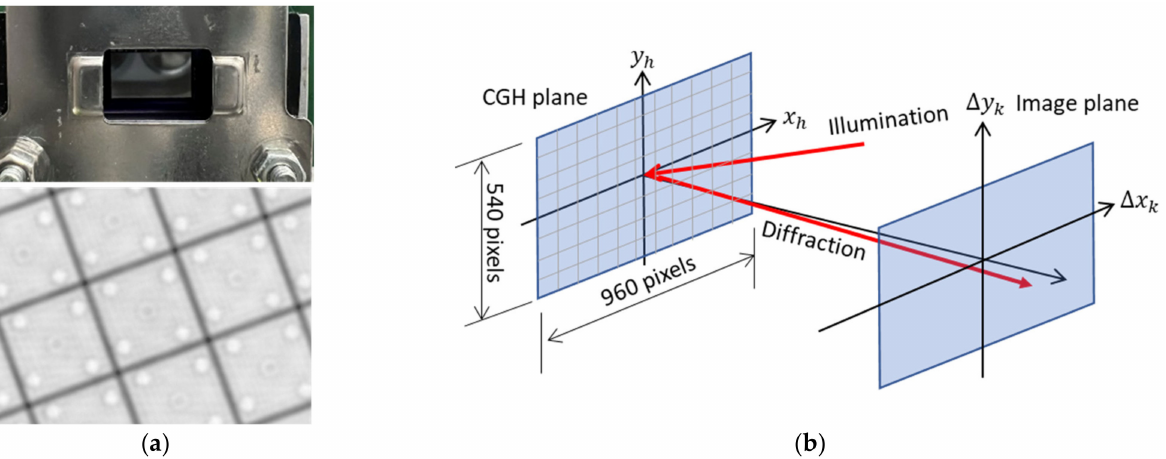
Figure 1. ( a ) The TI-PLM and image of pixels; ( b ) schematic diagram of the CGH plane ( x h , y h ) and the image plane ( ∆ x k , ∆ y k ) . For a given beam-steering angle ( ∆ x k / f , ∆ y k / f ) , the phase of the pixel located at ( x h , y h ) is calculated by Equation